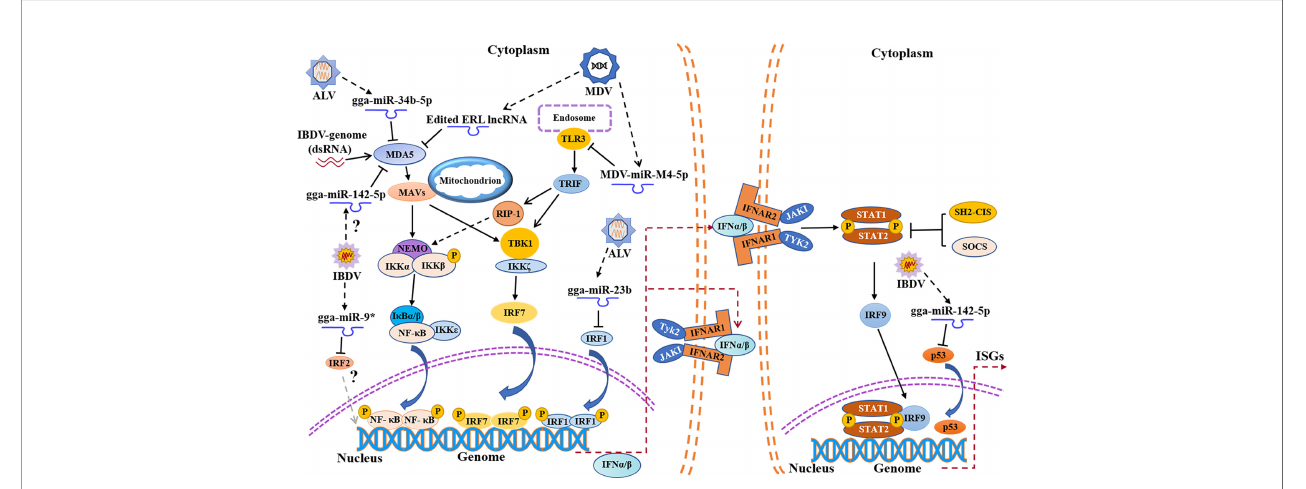
FIGURE 2 | Schematic diagram of avian immunosuppressive viruses expressing viral miRNAs or regulating host miRNAs expression to suppress host innate immune response. TLR3, Toll-like receptors 3; TRIF, TIR domain-containing adapter-inducing interferon- b ; RIP-1, receptor interacting